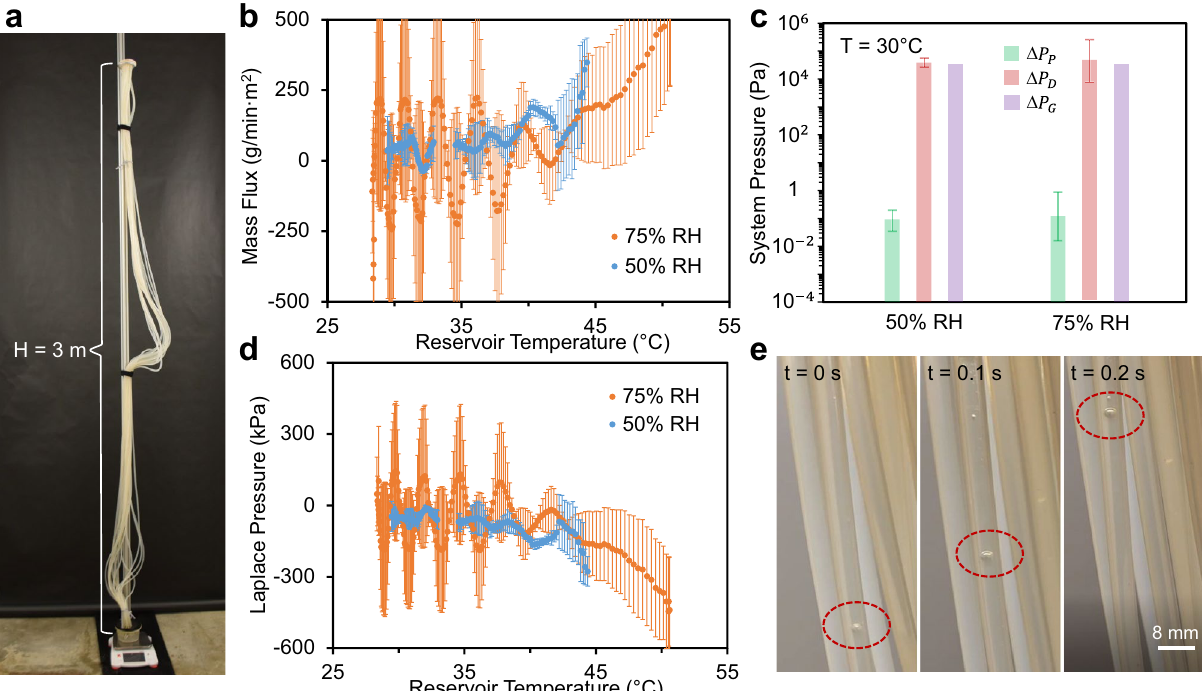
Figure 2. Demonstration of transpiration in a tall (3 m), scalable tree. ( a ) Photograph of the experimental setup, where the tubing and synthetic leaf are fixed to a tall vertical post. Transpiration is measured by placing the bottom reservoir on a mass balance, while the flow rate is controlled by tuning the ambient humidity of the tree growth chamber enclosing the entire tree. ( b ) Transpiration mass flux of the tall tree at 75% or 50% ambient humidities, as a function of the reservoir temperature recorded over 3 h experimental trials. ( c ) Pressure drops associated with the tall tree, calculated to match the flow rate measured at a reservoir temperature of 30 °C. ( d ) Calculated Laplace pressures of the tall tree at 75% and 50% ambient relative humidities, found as the sum of the three pressure drops. ( e ) During some trials, air bubbles (red circles) were periodically trapped within the tubes, resulting in the oscillatory backflow of the water. Graphical values in ( b – d ) are an average of three trials, while the error bars represent one standard deviation.